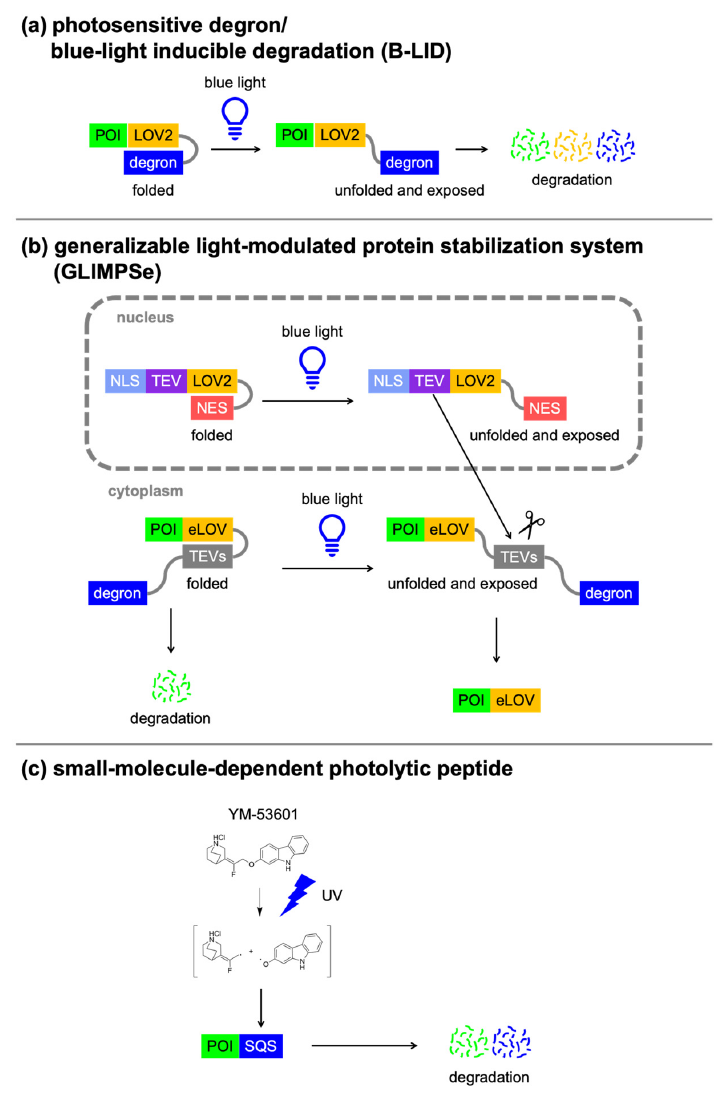
Figure 4. Light ‐ switchable degrons. Concepts of ( a ) photosensitive degron and B ‐ LID, ( b ) general ‐ Figure 4. Light-switchable degrons. Concepts of ( a ) photosensitive degron and B-LID, ( b ) general- izable light ‐ modulated protein stabilization system (GLIMPSe), and ( c ) small ‐ molecule ‐ dependent izable light-modulated protein stabilization system (GLIMPSe), and ( c ) small-molecule-dependent photolytic peptide. photolytic